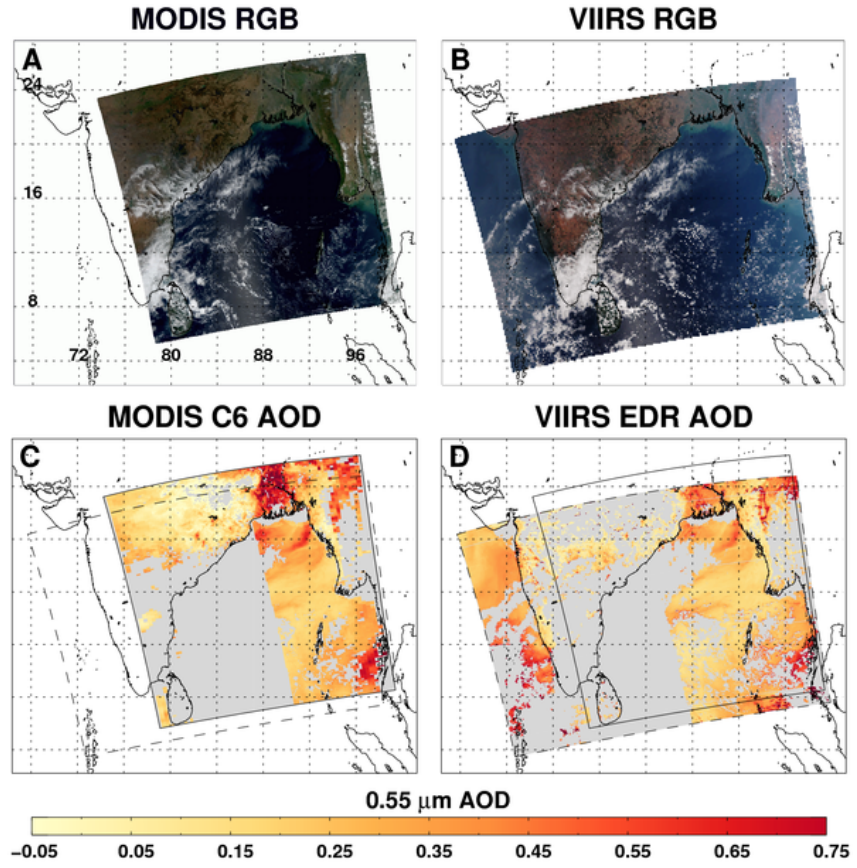
Figure 2. Overlap of MODIS and VIIRS centered on the Bay of Bengal, during a 5-minute period starting at 5 March 2013 at 07:35. ( a and b ) are true-color RGB images for MODIS and VIIRS. ( c and d ) are retrieved QA-filtered AOD at 0.55µm for the MODIS C6 (10km) and VIIRS EDR (6km) products. AOD are plotted based on published quality assurance recommendations for each